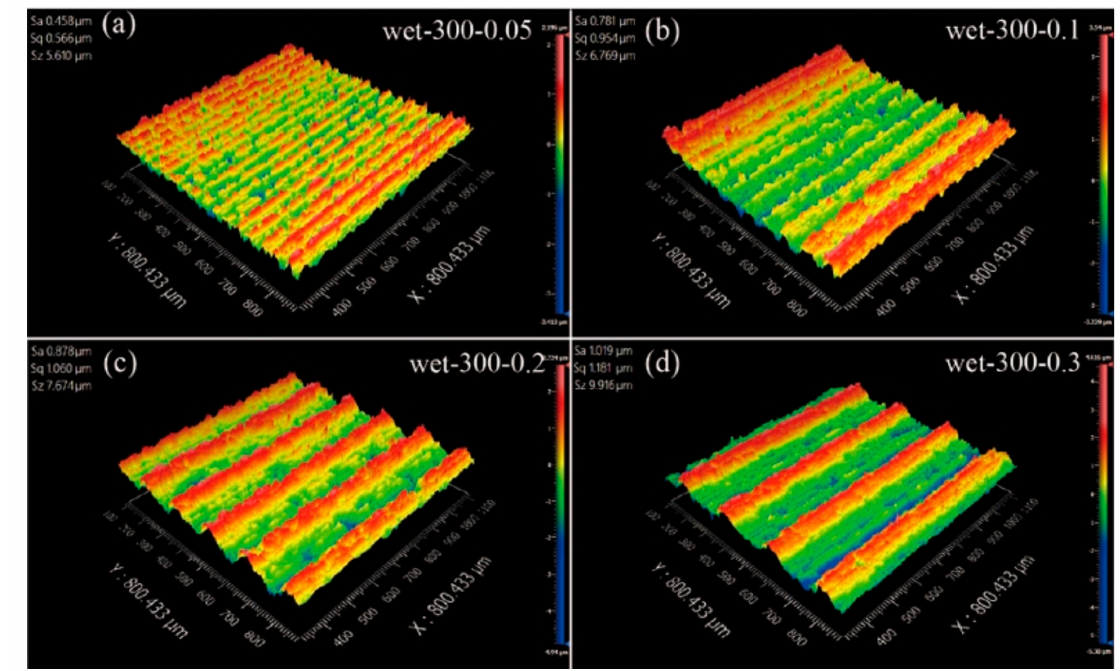
Figure 10. The surface morphology for wet cutting conditions with feed rates of ( a ) 0.05; ( b ) 0.1; ( c ) 0.2; ( d ) 0.3